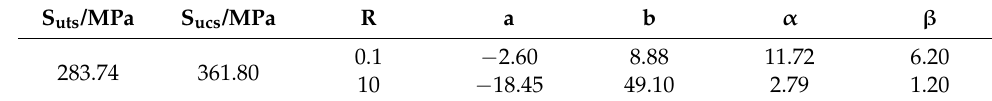
Table 3. Static strength and parameter values of the fatigue function and INT model.